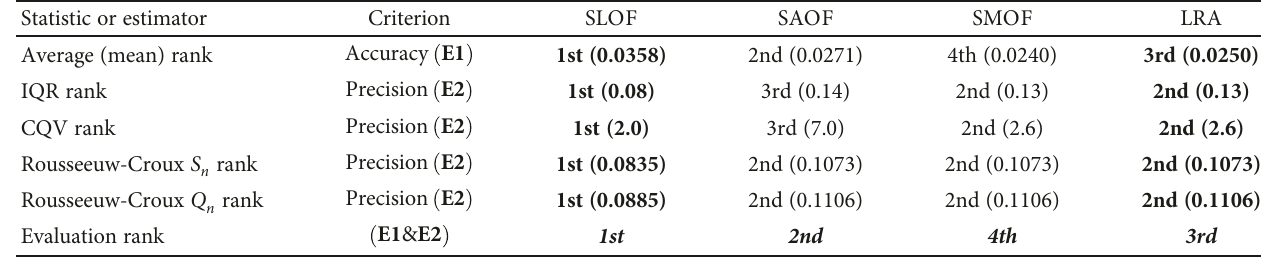
Table 4: Summary of criteria ranks and evaluation